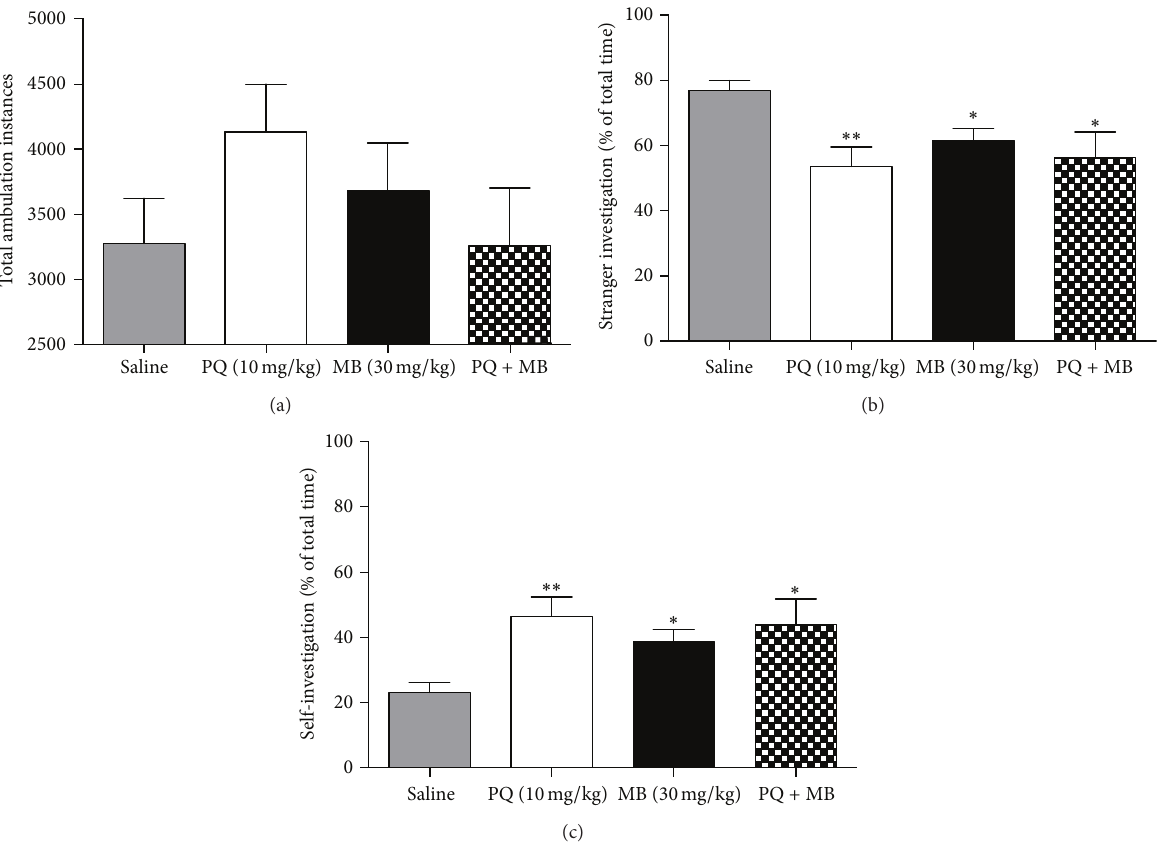
Figure 1: Pesticide treatment significantly alters olfactory discrimination, but not locomotor activity. PQ treated mice exhibited hyperactivity; however, these changes were not significant (a). Olfactory discrimination experiments revealed that all treatments caused a decrease in stranger investigation (b) and increased investigation of self (c). Data (mean ± SEM) analyzed via one-way ANOVA and Dunnett’s post hoc test ( ∗∗ 𝑃 < 0.01 ; ∗ 𝑃 < 0.05 ). 𝑁 = 10–12 animals per treatment